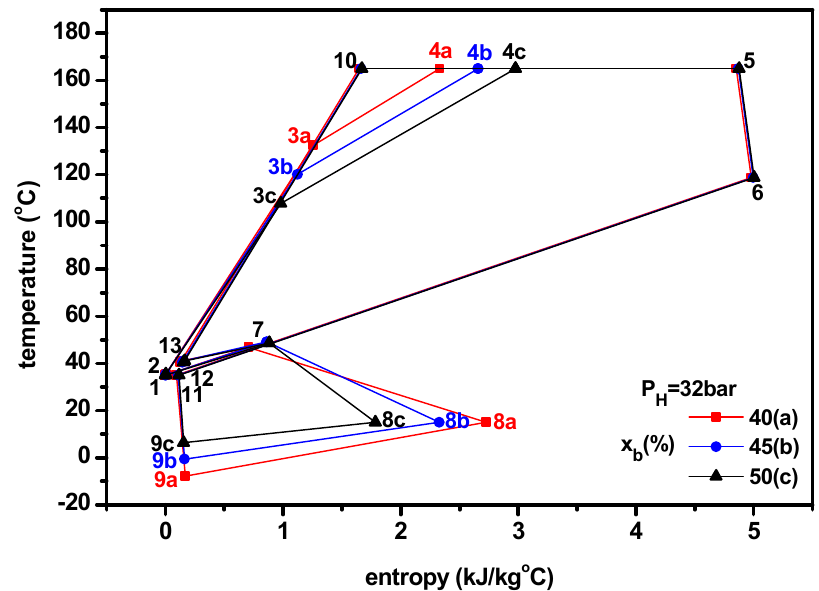
Figure 3. Temperature-entropy diagram for different separator pressures.